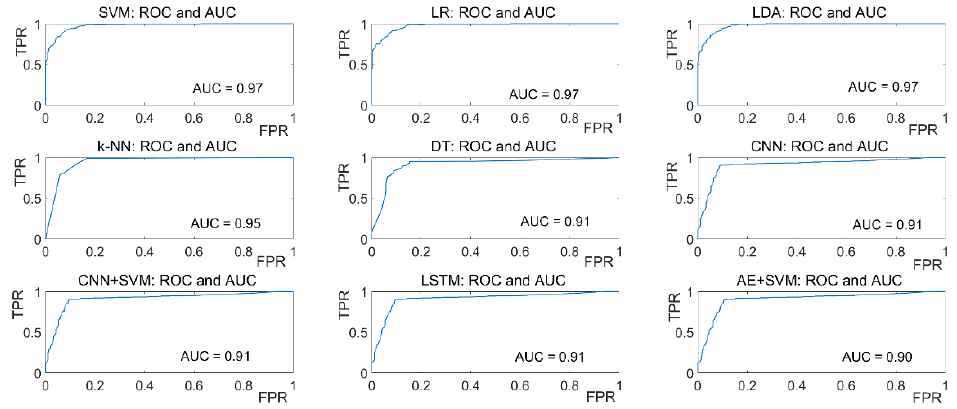
Figure 17. ROC and AUC for ML classifiers considering the eyeT system.